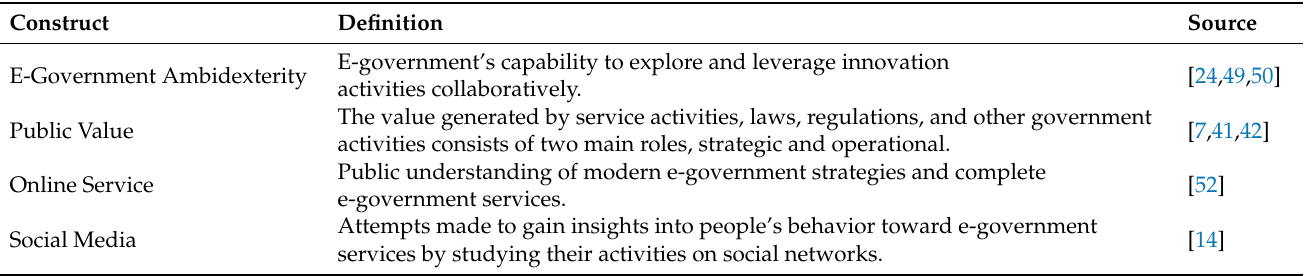
Table 1. Construct